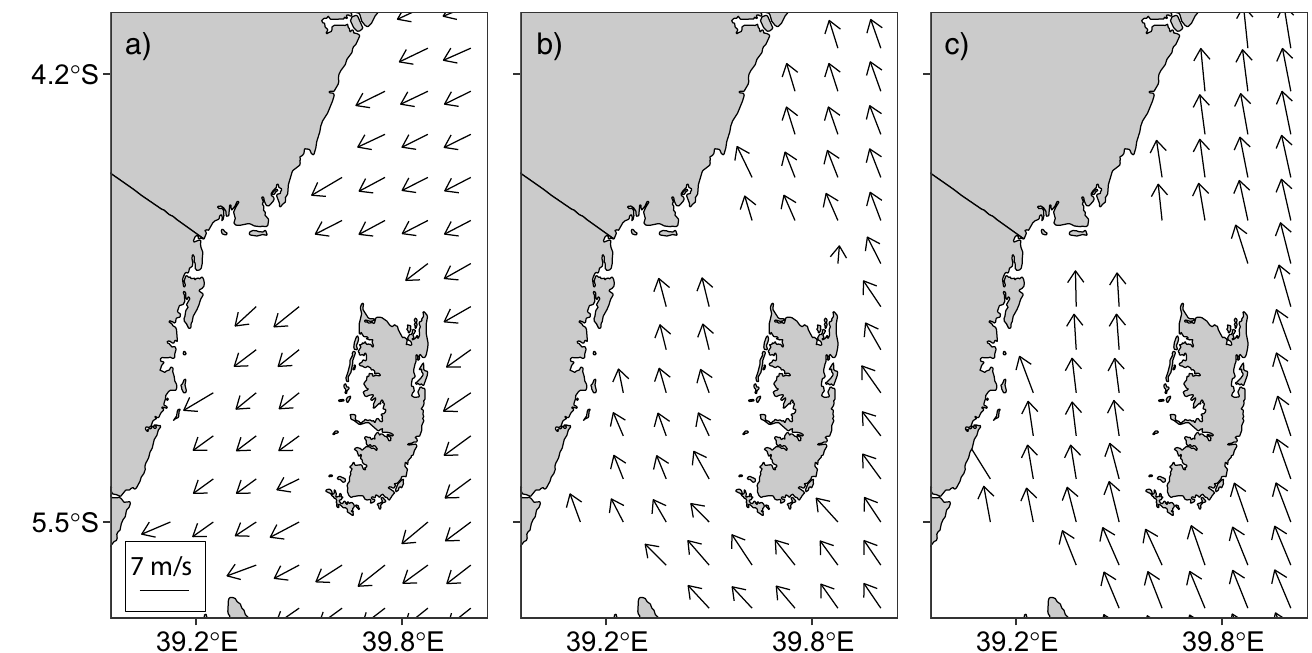
Fig 11. Wind vectors derived from QuikSCAT showing wind speed and direction in the Pemba Channel during a) NE, b) IN and c) SE monsoon seasons.